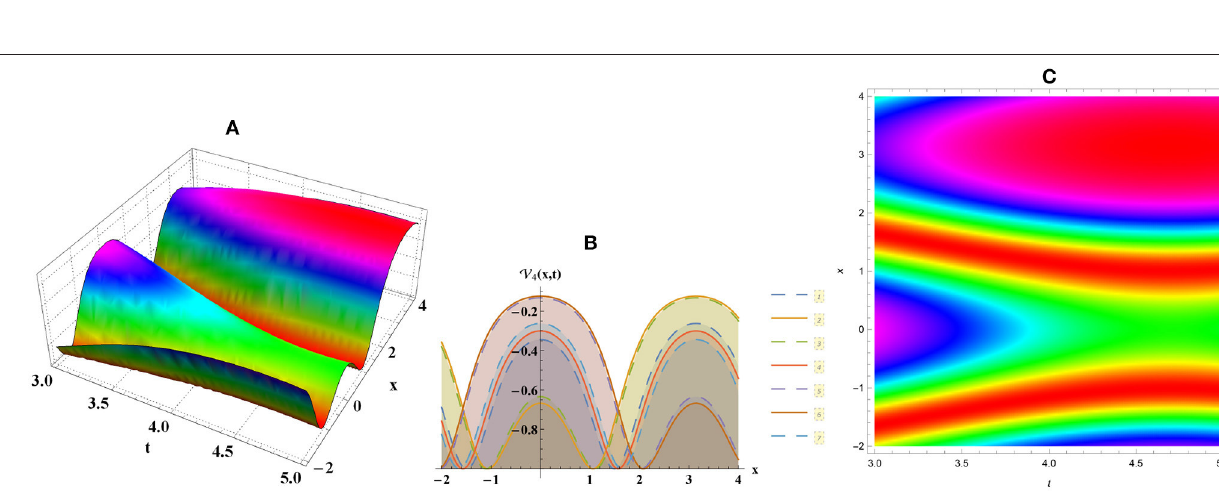
Frontiers in Physics |